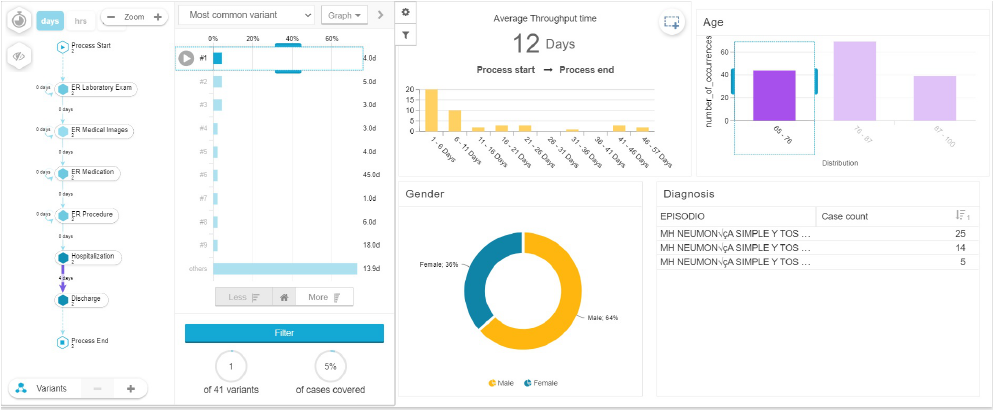
Figure 6. Length of stay of patients between 65 and 76 years of